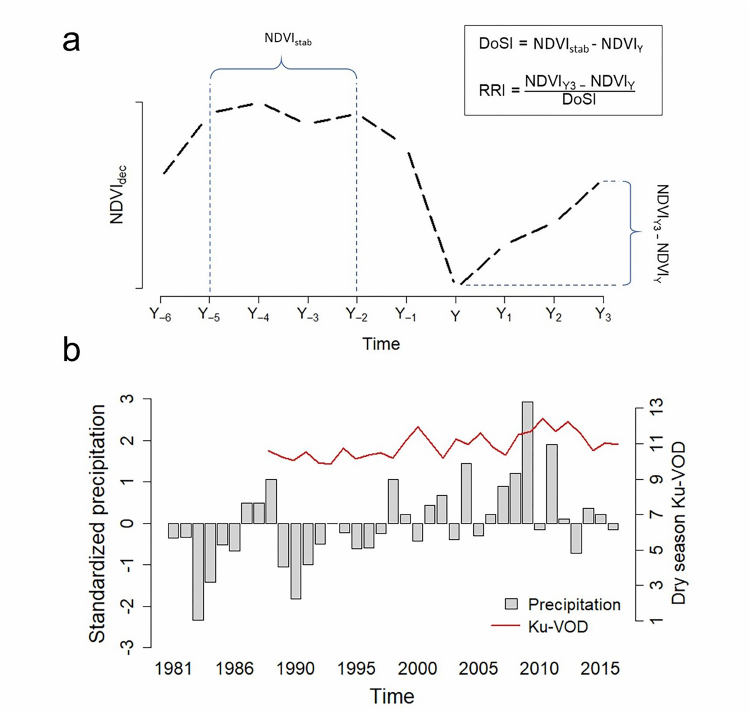
Figure 2. ( a ) Schematic time series highlighting periods and years used for the calculations of the DoSI and the RRI (the latter was adapted from Reference [75]). The post-drought woody vegetation state is represented by the time step “Y” (with Y corresponding to 2015), and the stable period before the drought (2010–2013) as “NDVI stab ”. ( b ) Standardized precipitation, calculated as the annual precipitation anomaly divided by the standard deviation, and summed dry season Ku-VOD for the study area. The extreme and severe droughts in the 1980s and 1990s, respectively, the years of above-normal precipitation in 2008–2012, and the mild drought in 2014 are